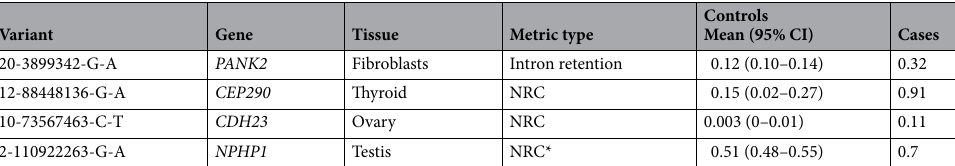
Table 1. Metrics obtained from the analysis of GTEx v7 datasets to observe the impact of variants prioritized as splice impacting. Our analysis identified 4 variants in autosomal recessive genes that were present in a carrier state in individuals in GTEx v7 and had observable impacts on splicing in these individuals. Metrics were calculated from aligned RNAseq datasets from tissues with a transcript per million value > 5 for the gene of interest. Cases, individuals within the GTEx dataset carrying prioritized variant. Controls , a group of ten randomly selected individuals within the GTEx dataset that do not carry the prioritized variant. NRC normalized read count (described in “Supporting Information”). *switch in usage of two canonical exon junctions in alternative